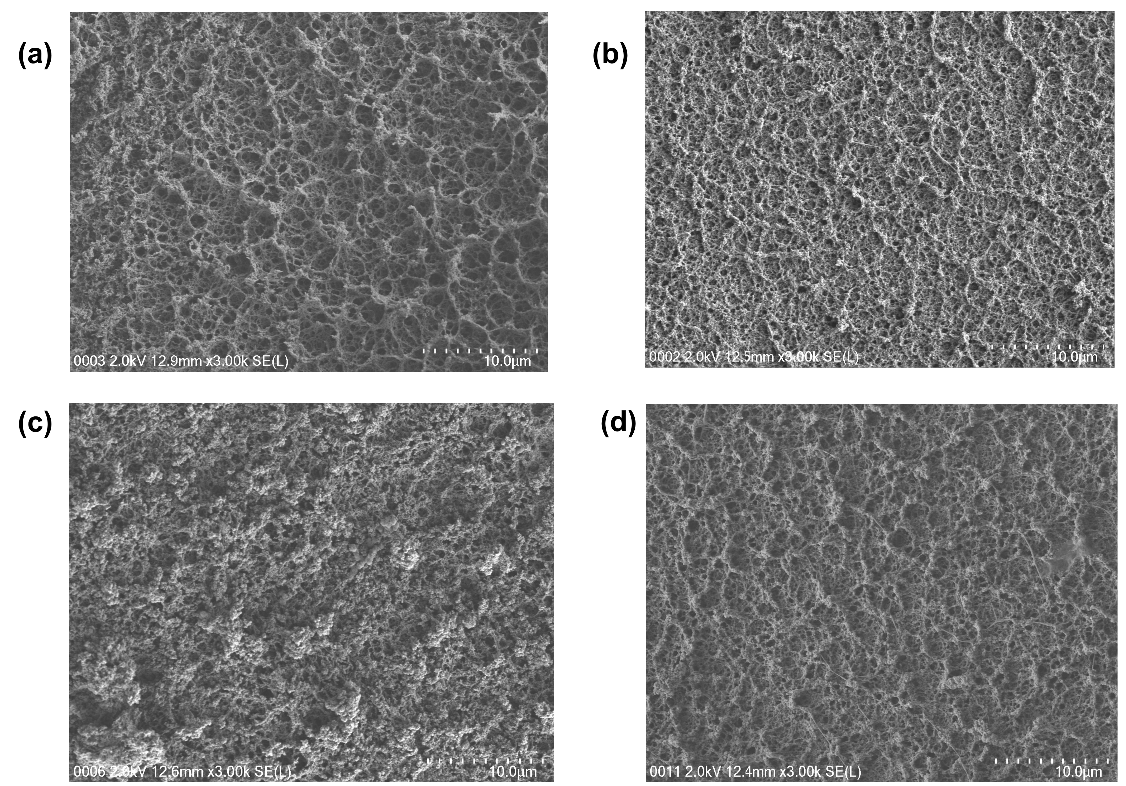
Polymers 2022 , 14 , x 13 of 23